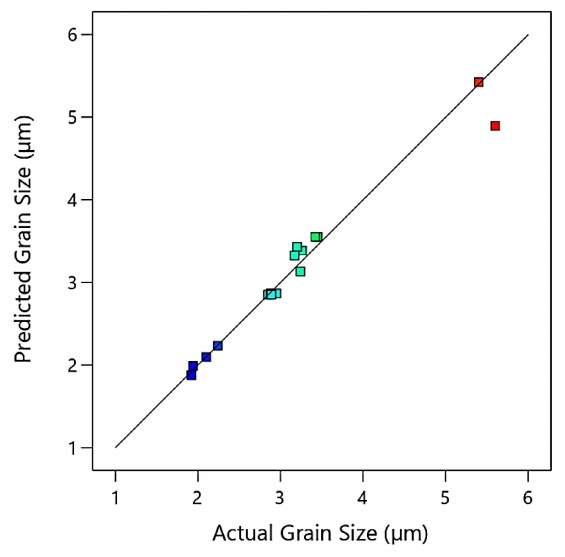
Figure 3. Predicted versus actual values of grain size, where the blue points are for minimum output value and gradually changed to red points for maximum output value.